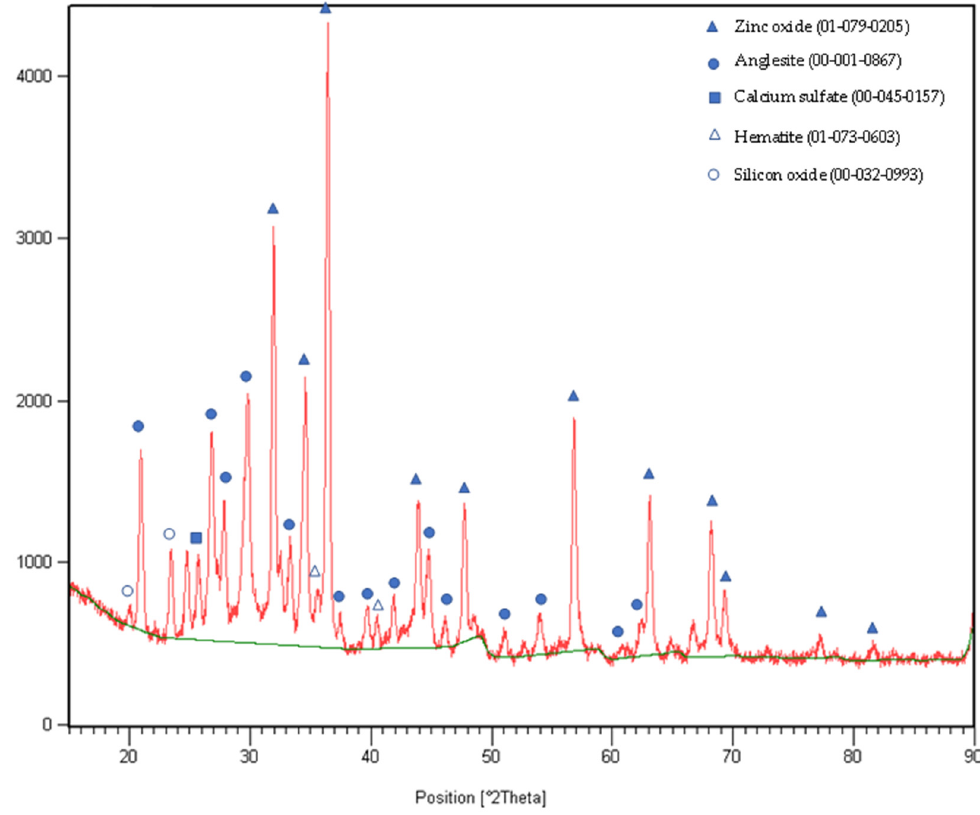
Figure 3. XRD pattern of the electric furnace flue dust. The SEM micrographs in Figure 4 show that this waste is composed by spherical par- ticles with different sizes, but most of them smaller than 5 μ m. This was an important parameter to be considered when deciding the average particle size of the reducing agent.